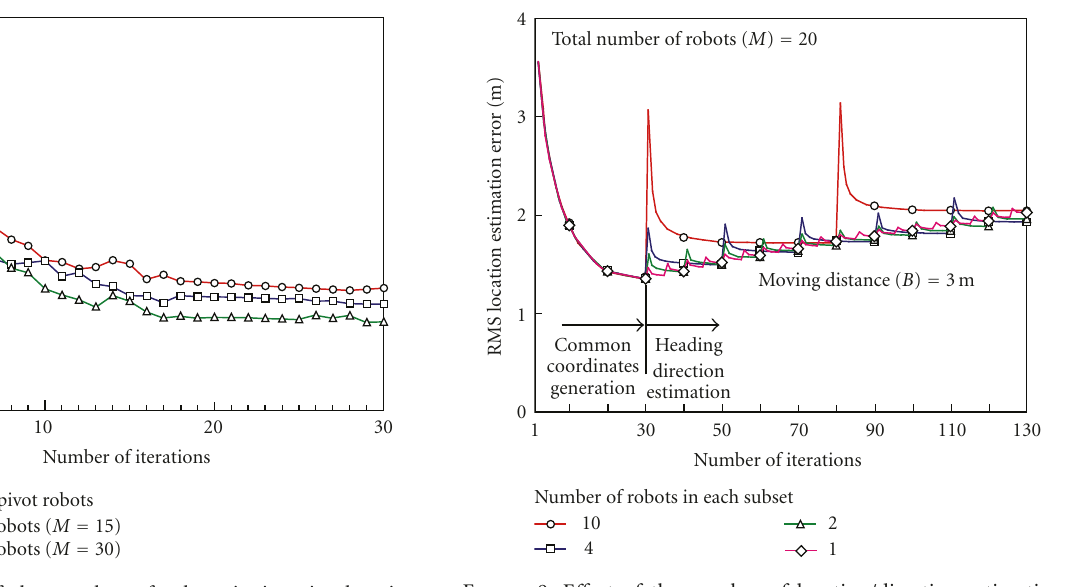
Figure 7: E ff ect of the number of robots in iterative location estimation.